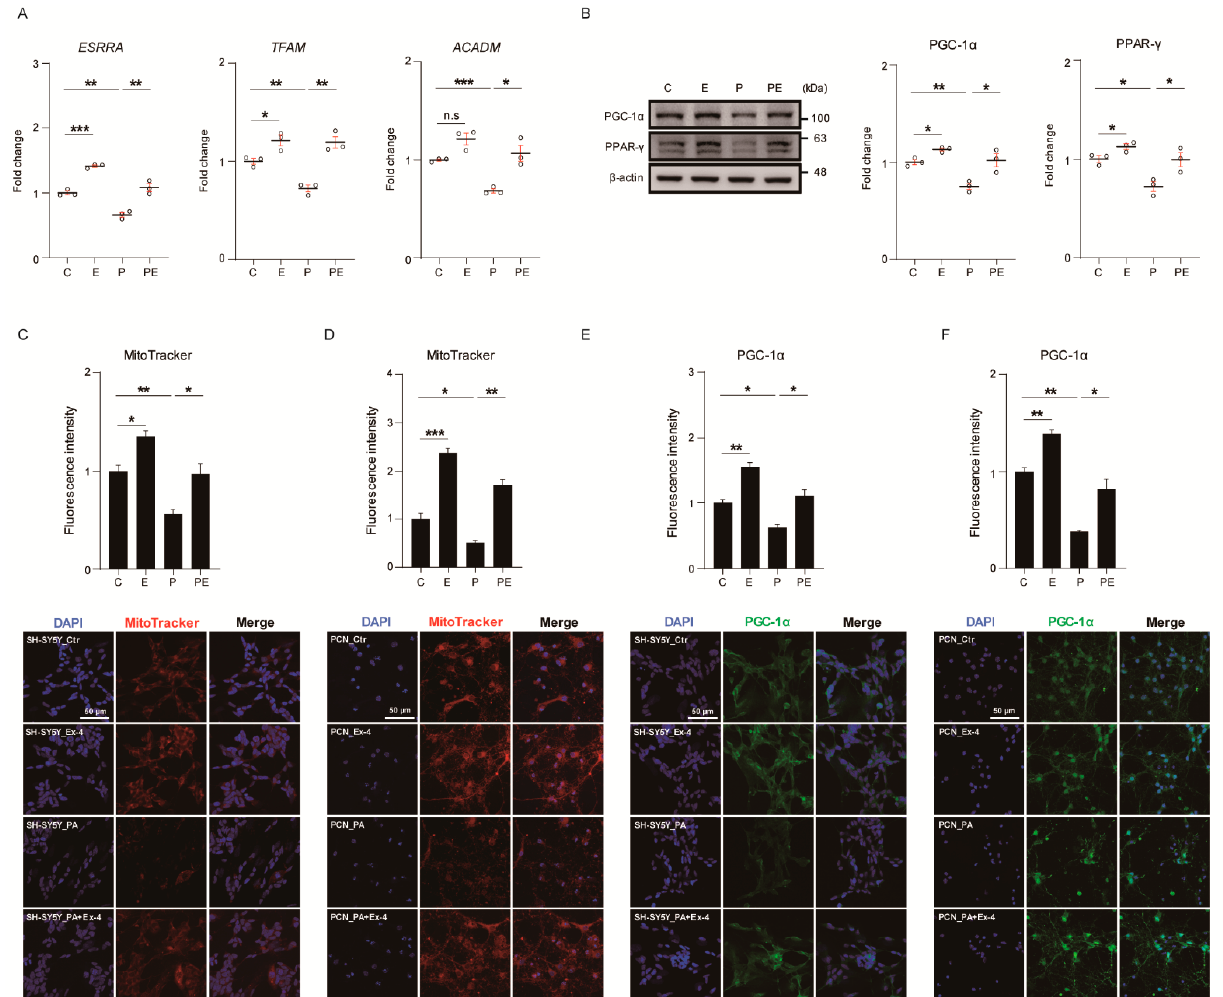
Figure 3. Exendin-4 improves the mitochondrial function of neurons against palmitic acid-induced oxidative stress. ( A ) Comparison mRNA expression of mitochondrial biogenesis ESRRA , mitochondrial transcription factor TFAM , and ACADM enzyme in SH-SY5Y cells treated with vehicle (C or Ctr), Exendin-4 (E or Ex-4), palmitic acid (P or PA), and both palmitic acid and Exendin-4 (PE or PA+Ex-4). The mRNA level of each gene is normalized to GAPDH level. ( B ) Western blot of metabolic process related protein expression in SH-SY5Y cells treated with reagents described in A. Each protein level is normalized to β -actin. ( C , D ) Fluorescent images of mitochondrial membrane potential with specific dye Mito-tracker (200 nM) in SH-SY5Y cells, and PCN neurons at DIV7 treated with reagents described in A. Nuclei were counterstained with DAPI (blue) and active mitochondria stained with MitoTracker deep red (red), >100 (E) and >50 (F) cells per group were analyzed. Scale bar: 50 μ m. ( E , F ) immunocytochemistry images of PGC-1 α expression in SH-SY5Y cells, and PCN neurons at DIV7 treated with reagents described in A. Nuclei were counterstained with DAPI (blue) and insulin receptor stained with PGC-1 α (green), >100 ( E ) and >50 ( F ) cells per group were analyzed. Scale bar: 50 μ m. Data information: SH-SY5Y cells were treated with 10 nM of Exendin-4 and 50 μ M of palmitic acid per group, according to the treatment plan (Figure S1B,C). In ( A – F ), error bars represent S.E.M. from three independent experiments. n.s p > 0.05, * p < 0.05, ** p < 0.01, *** p < 0.001 (unpaired two-tail t-tests with Welch’s correction).